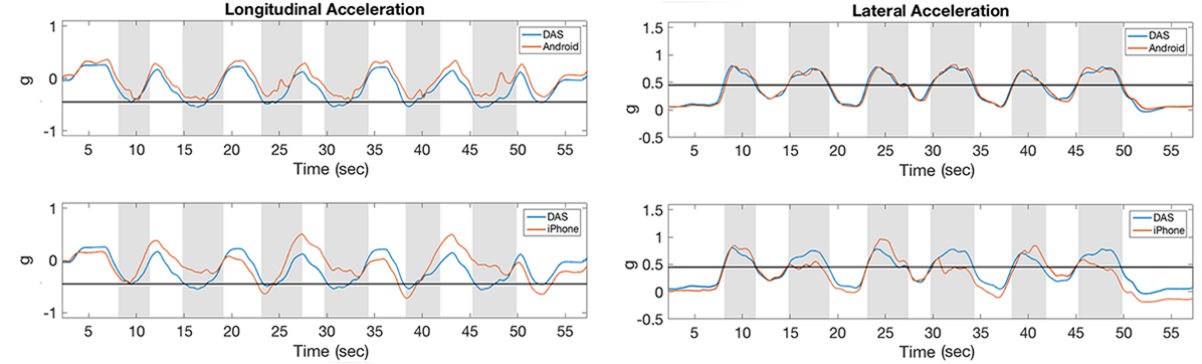
Figure 10. Acceleration measurements for hard left turning maneuvers. The horizontal line along longitudinal and lateral accelerations represents thresholds of –0.45 g and 0.45 g, respectively. Shaded stripes identify the approximate time of the turning maneuvers. DAS: data acquisition